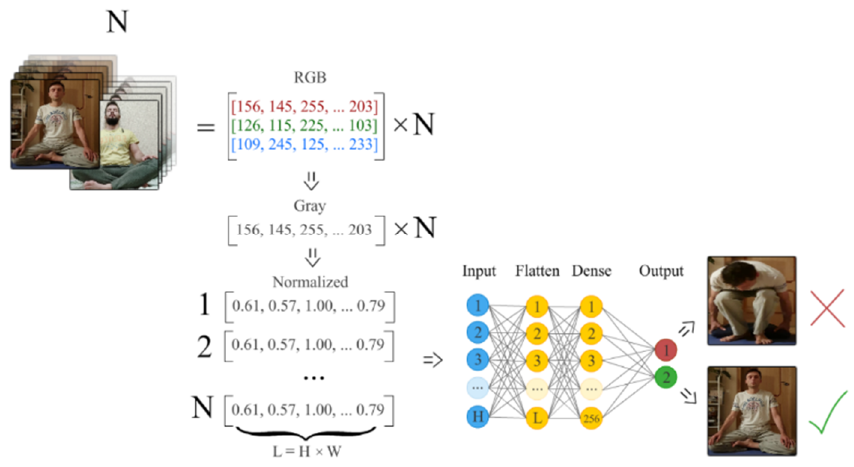
Figure 15. Image normalization before training the neural network.